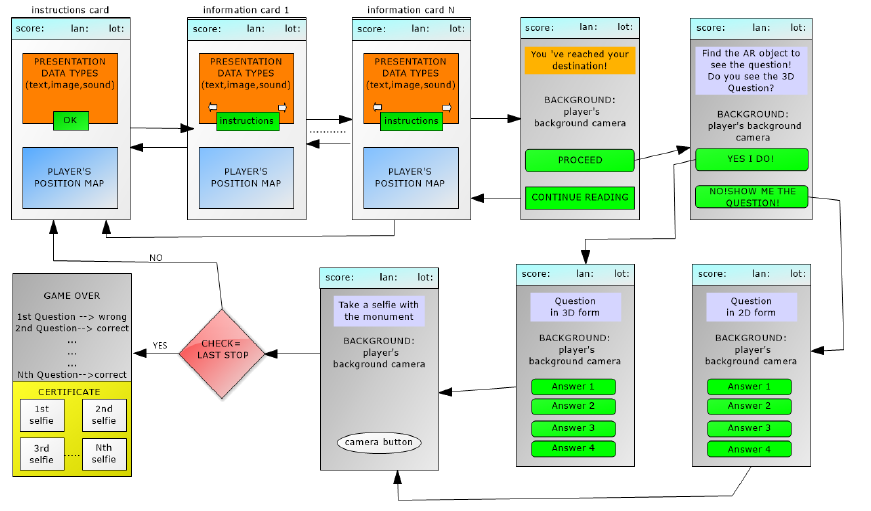
Figure 4. Flow diagram of the